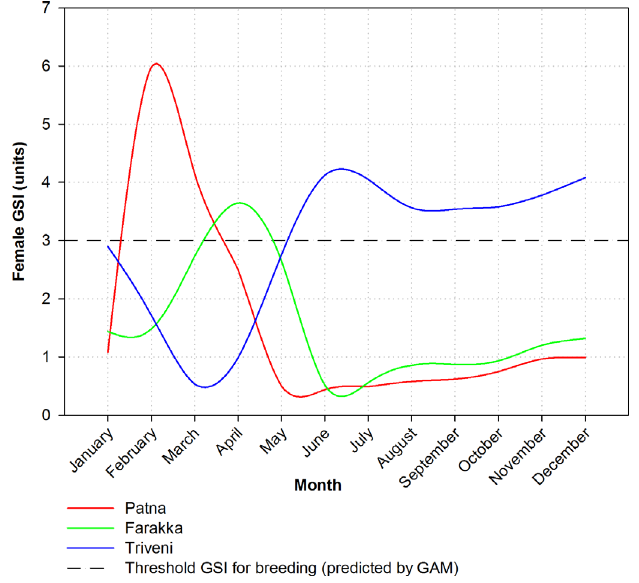
Fig. 2. Annual trend of female GSI of J. coitor along various stretches of river Ganga.